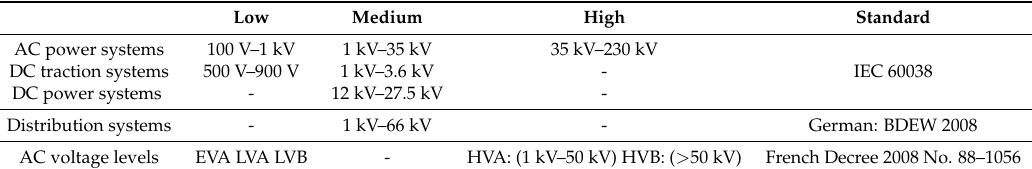
Table 1. Overview of voltage standards discussed in Section 4.1